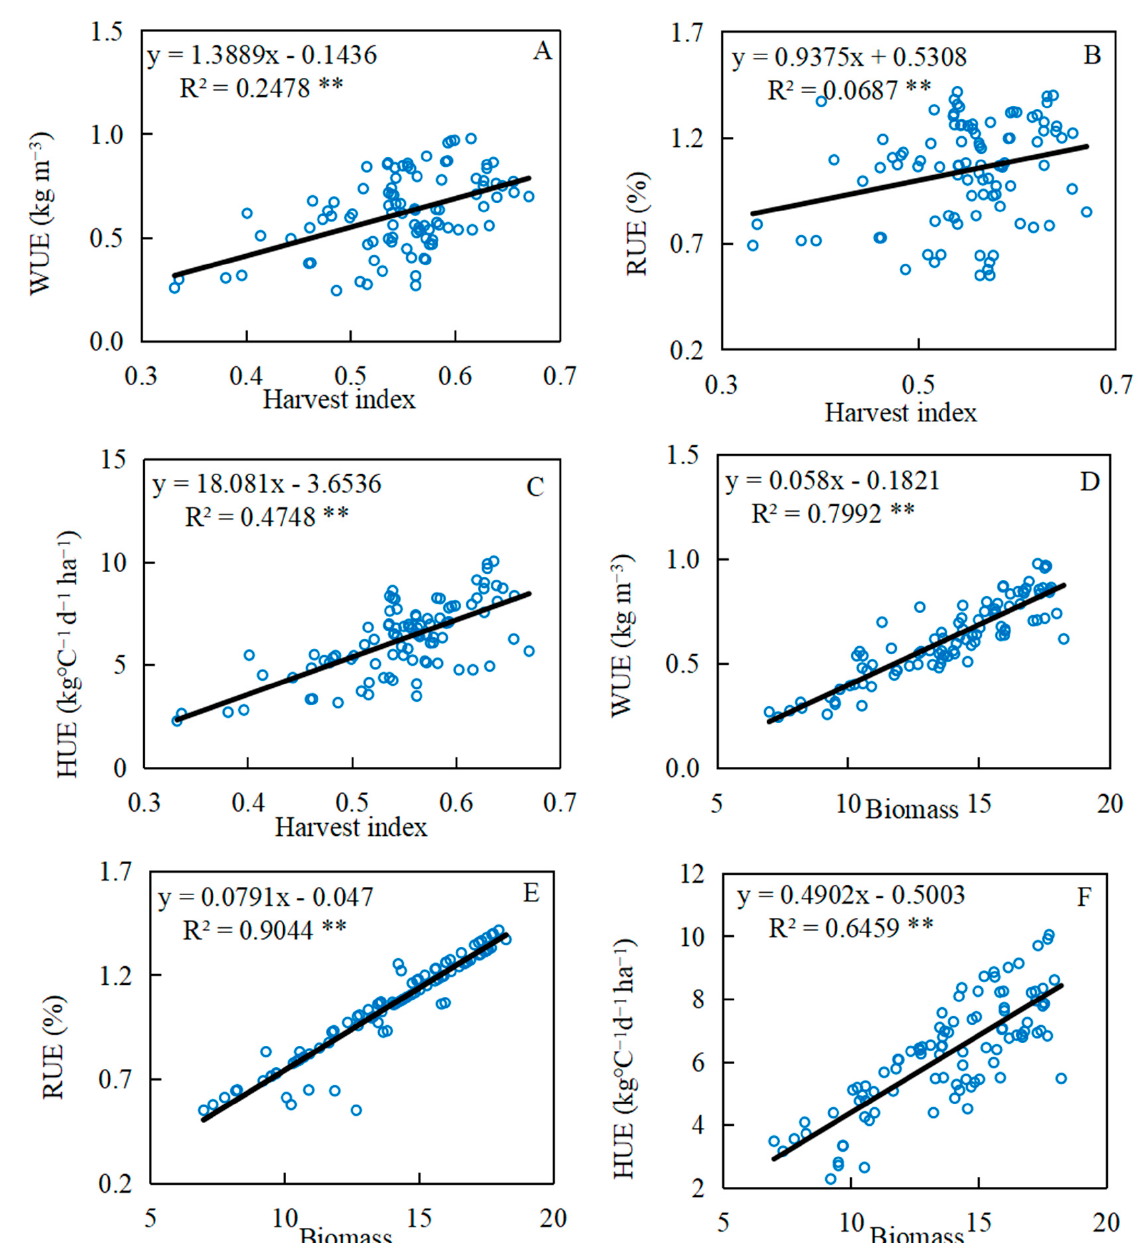
Figure 8. Correlations between the harvest index and water-use efficiency (WUE) ( A ), radiation-use efficiency (RUE) ( B ), and heat-use efficiency (HUE) ( C ); and biomass and WUE ( D ), RUE ( E ), and HUE ( F ) throughout the growth period. **: Significant at 1% probability levels.